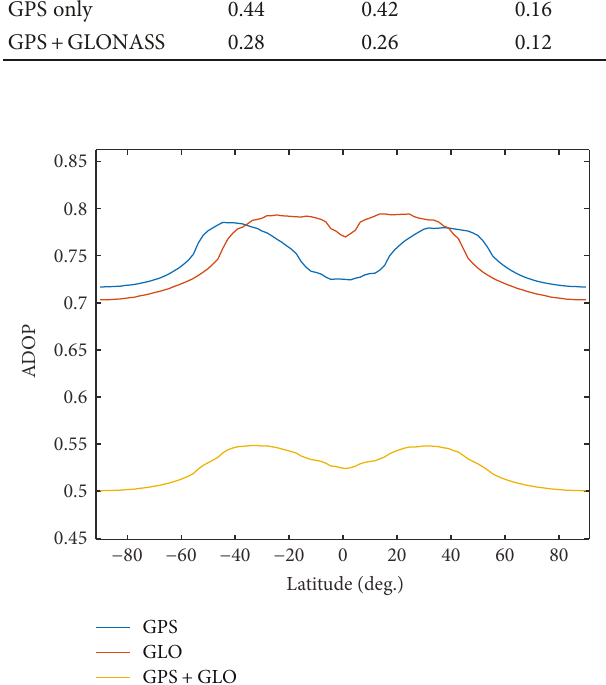
Figure 4: ADOP calculated along one meridian, averaged over a 24-hour period for the GPS constellation, for the GLONASS constellation, and for both constellations.